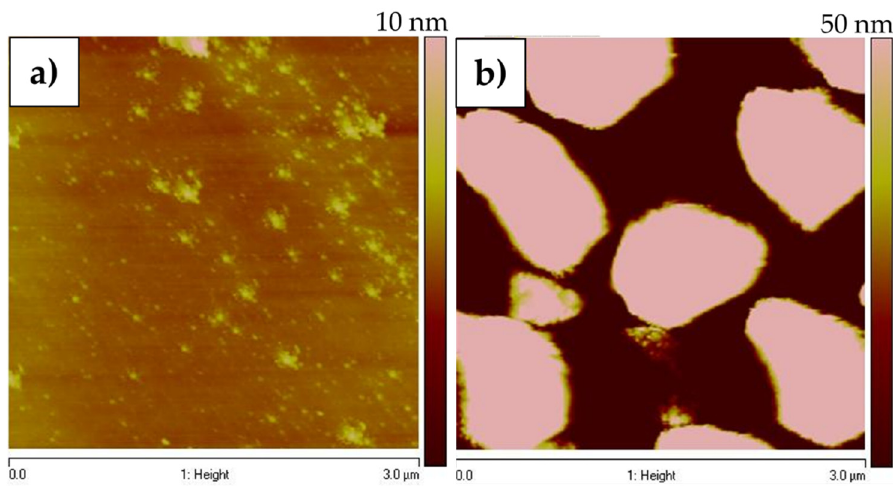
Figure 5. AFM measurements of the graphene growth on SiO 2 /Si substrate: ( a ) and ( b ) show the AFM images taken next to and on top of the copper-strip, respectively.